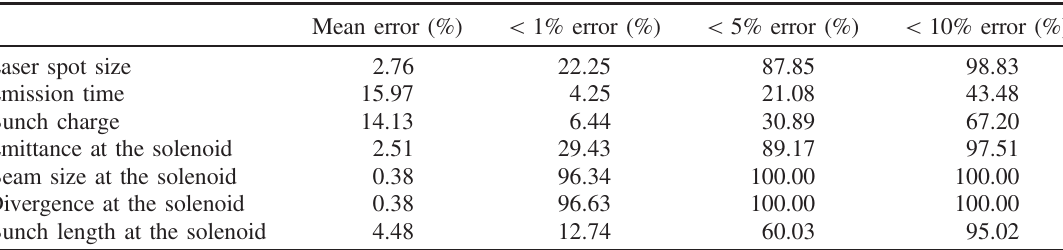
TABLE III. Summary of the prediction performance of the modified network for the different training label components. The mean error refers to the absolute prediction error and is calculated for the whole verification dataset. The three remaining columns refer to the fraction of the verification dataset within a certain prediction accuracy interval.